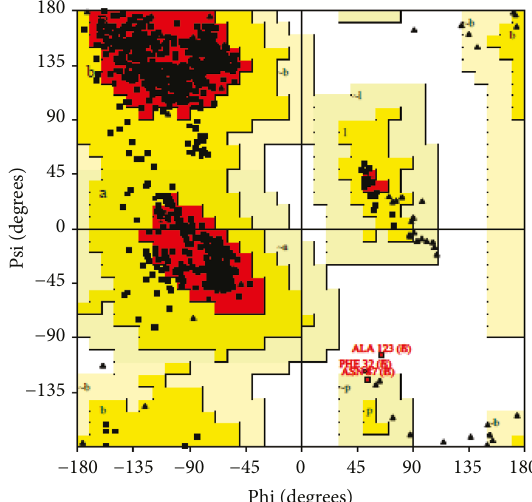
Figure 3: Ramachandran plot of SARS-CoV-2-SG by PROCHECK server.